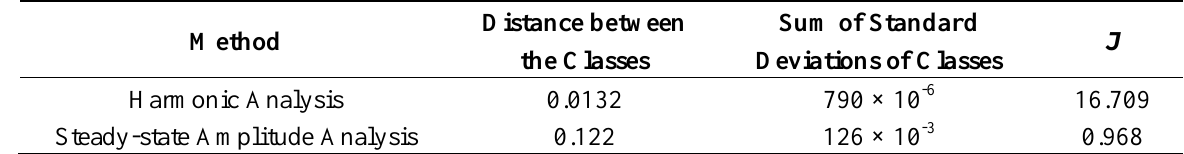
Table 1. Quantitative comparison of discrimination capabilities of the steady-state and harmonic analysis at different humidity